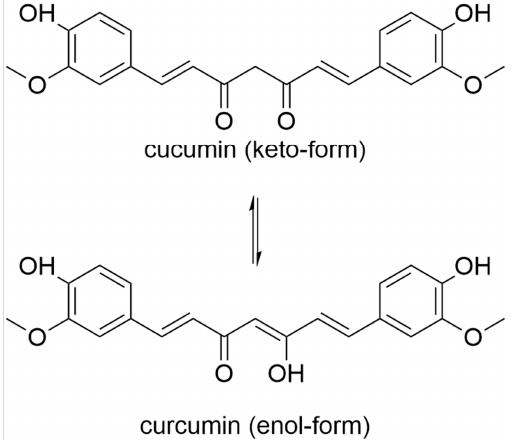
Figure 6. Structure of curcumin in two tautomeric forms.